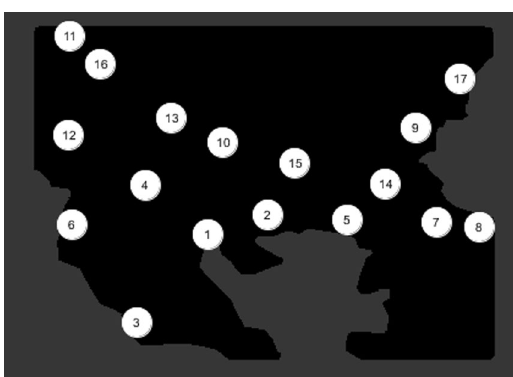
Figure 7. Numbers corresponding to Balkan regions (Figure and data points from custom Processing script (https://www.processing.org/) by author